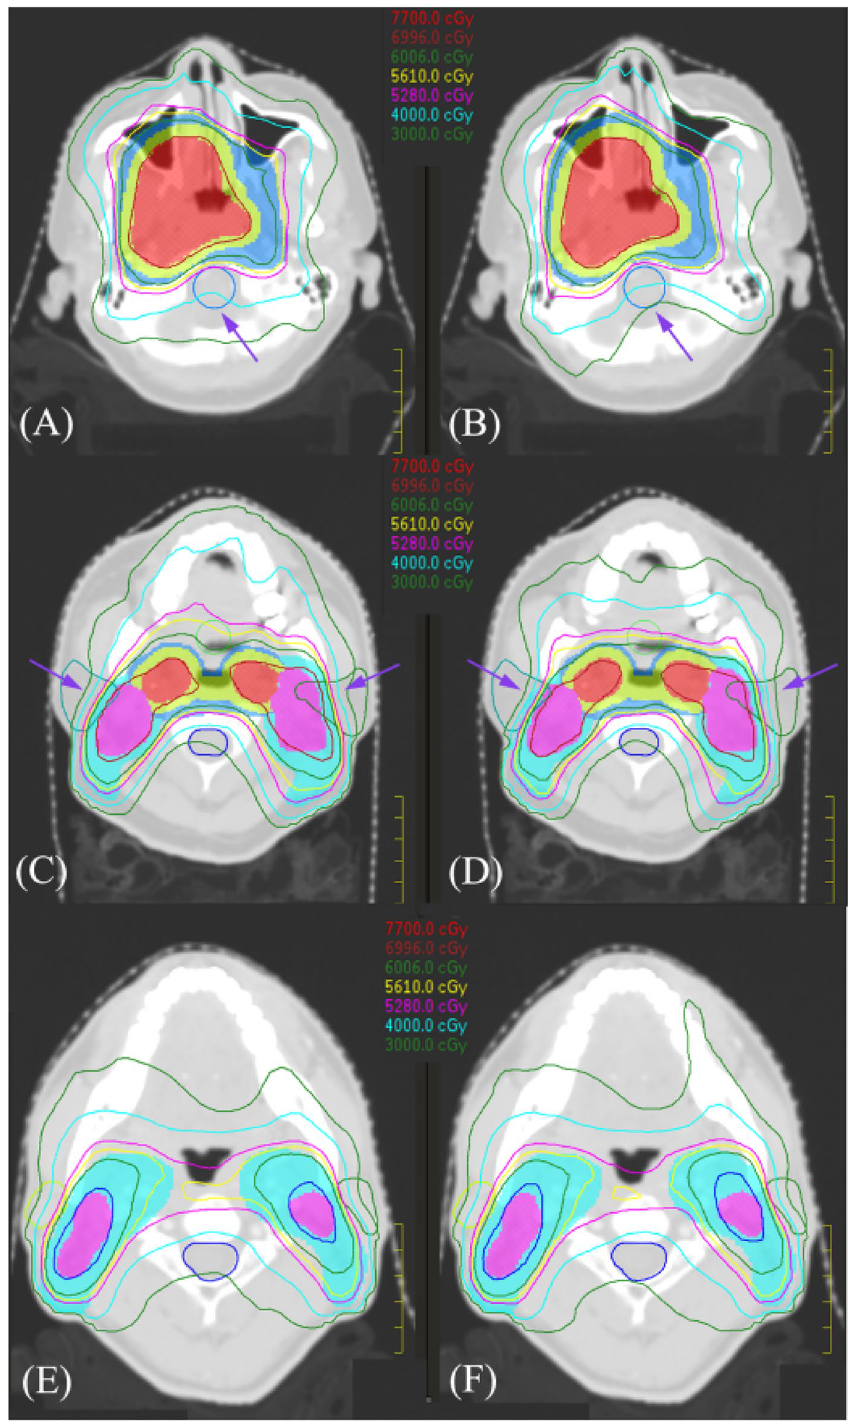
Figure 1. The dose distributions for two representative NPC patients were displayed. ( A ): manual plan, ( B ): automatic plan for a patient with stage III (T3N2M0); ( C ): manual plan, ( D ): automatic plan for a patient with stage IV (T4N3M0); ( E ): manual plan, ( F ): automatic plan for a patient with stage IV